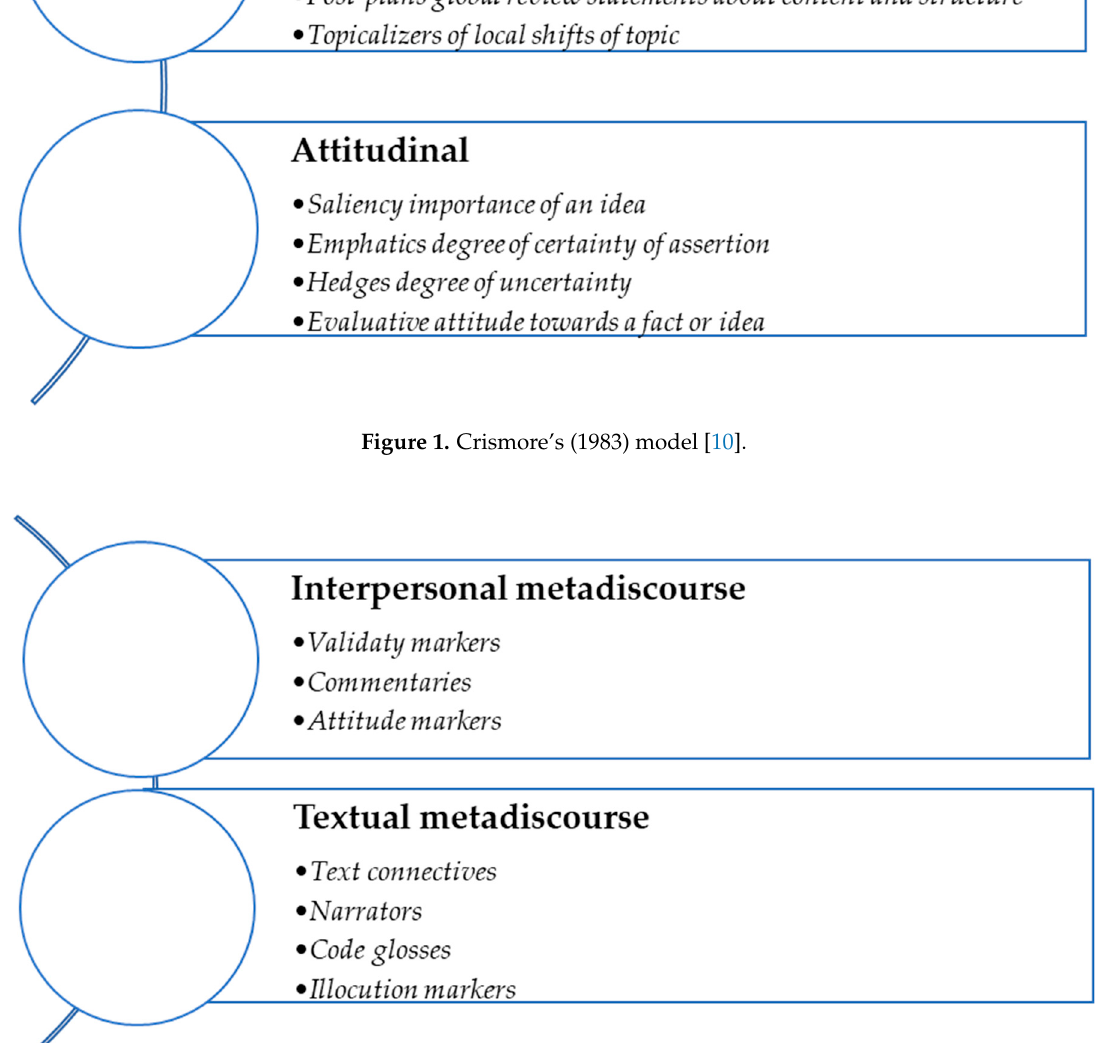
Figure 1. Crismore’s (1983) model [10].